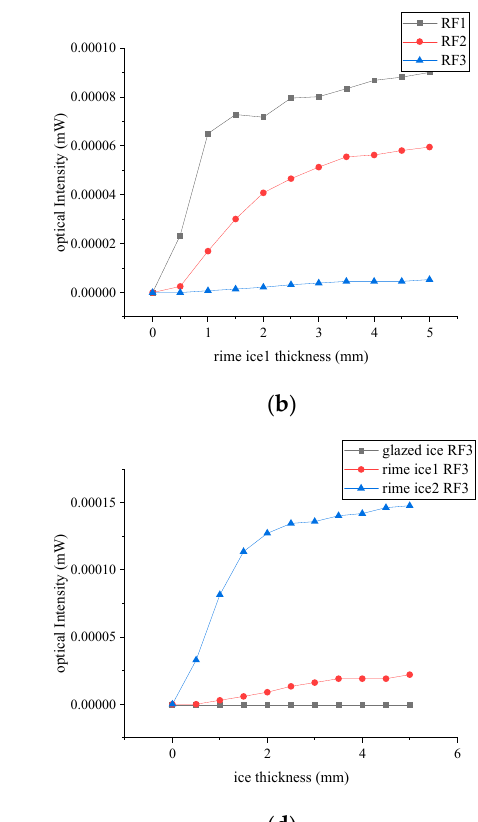
Figure 4. Schematic diagram of the coupling process between the re fl ected spot and the receiving fi ber. ( a ) Re fl ected spot does not coincide with the receiving fi ber end face; ( b ) Re fl ected spot partially coincides with the receiving fi ber end face; ( c ) Re fl ected light spot completely covers the receiving fi ber end face .